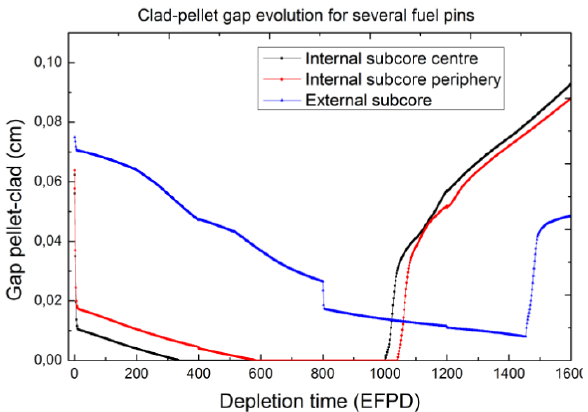
Fig. 5. Typical gap size evolution for chosen sub-assemblies (in top fi ssile zone).